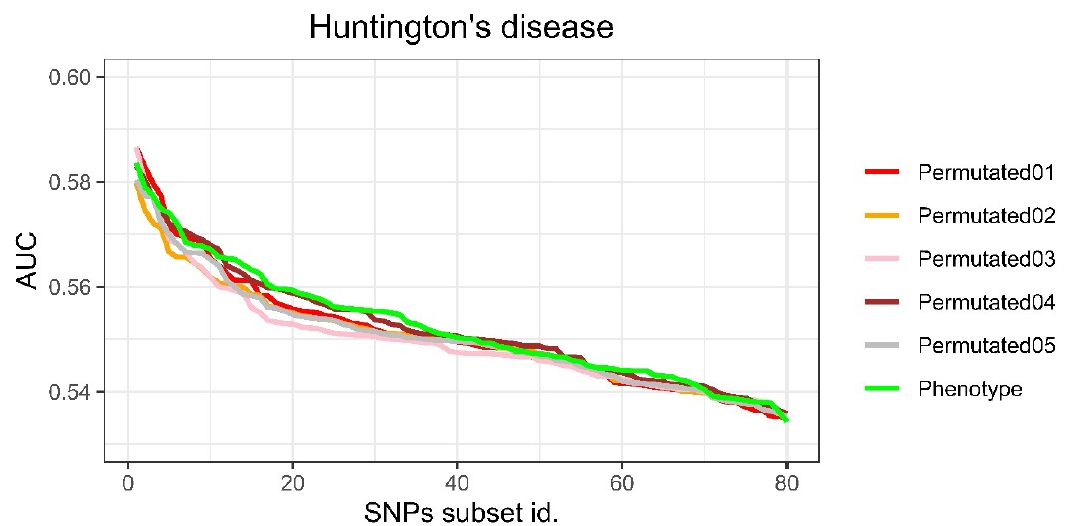
Figure 10. AUC values of the 80 iterations performed for the glucagon signaling pathway in the case of cases and controls (phenotype) and five different permutations.